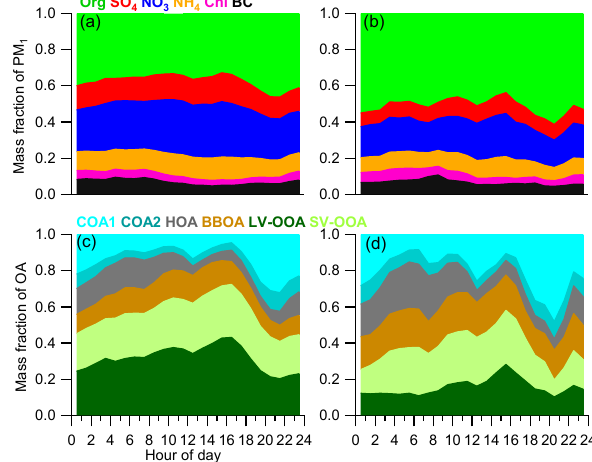
Figure 4. Diurnal evolution of the composition of PM 1 and organic aerosol (OA) measured (a, c) before the Asia-Pacific Economic Co- operation summit (APEC) and (b, d) during